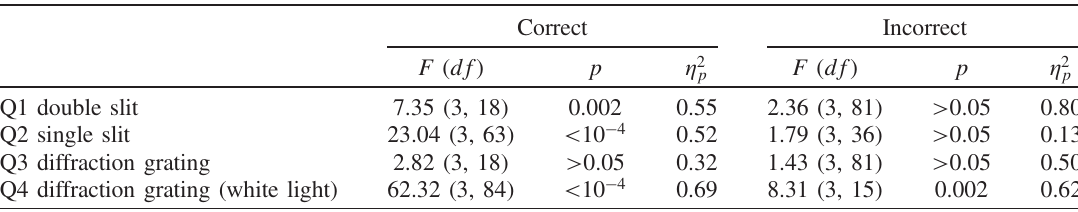
TABLE II. Results of the one-way ANOVAs conducted on dwell times for multiple-choice answers ( a , b , c , and d ) for each question, separately for students who correctly and incorrectly answered the question.